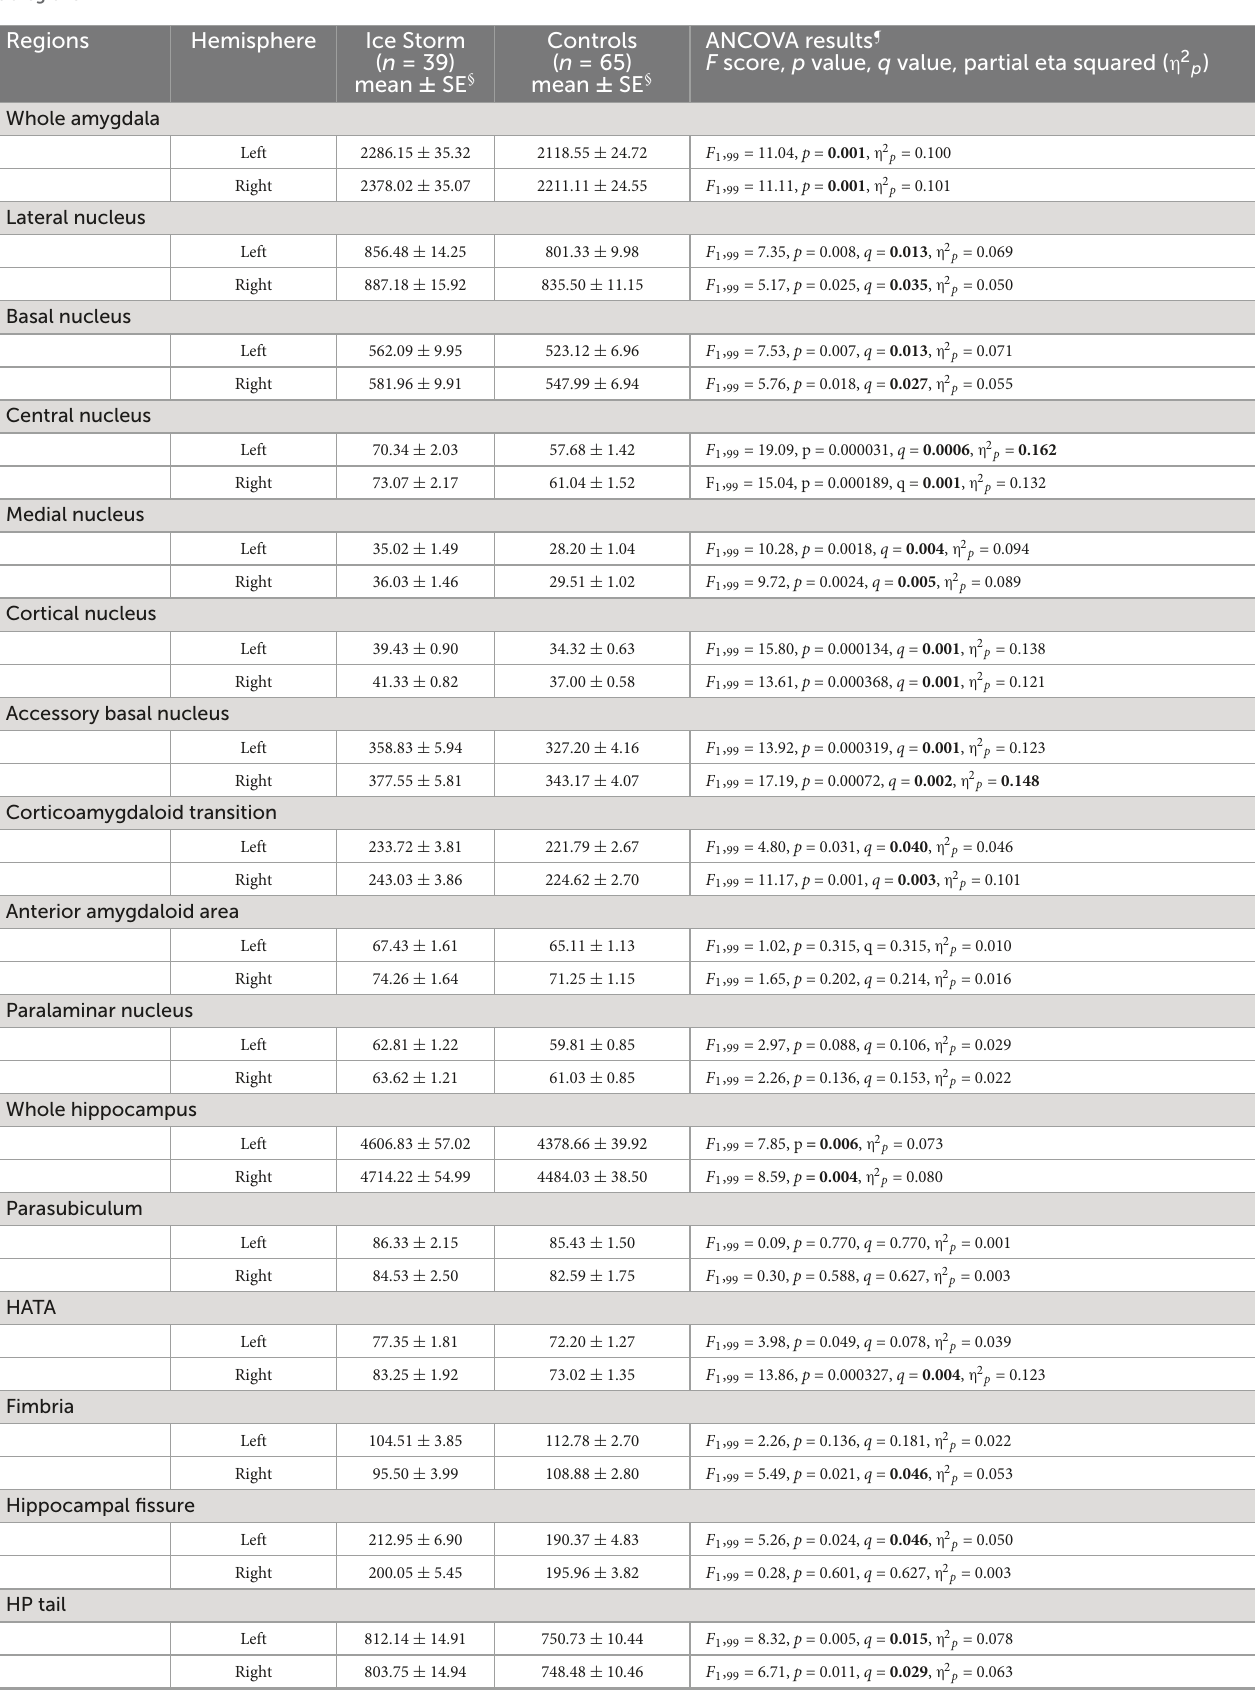
Controls ANCOVA results ¶ F score, p value, q value, partial eta squared ( η 2 p ) ( n = 39) ( n = 65) mean ± SE § mean ± SE §